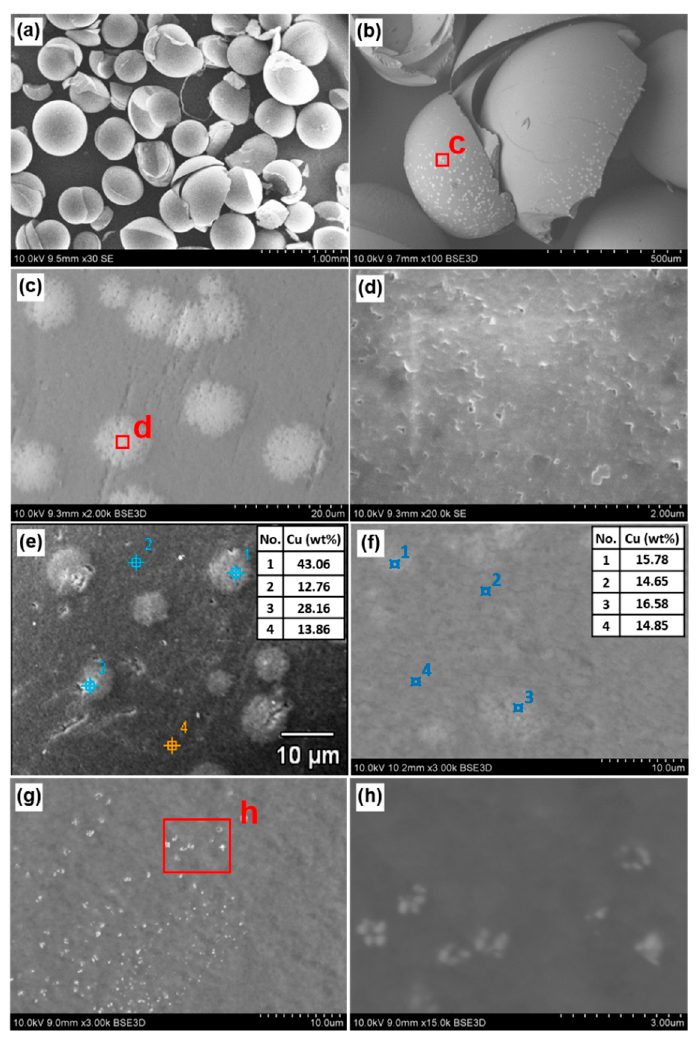
Figure 3. SEM images and EDS analysis of the M/An/Cu ( a )–( e ) surface, ( f )–( h ) inside.